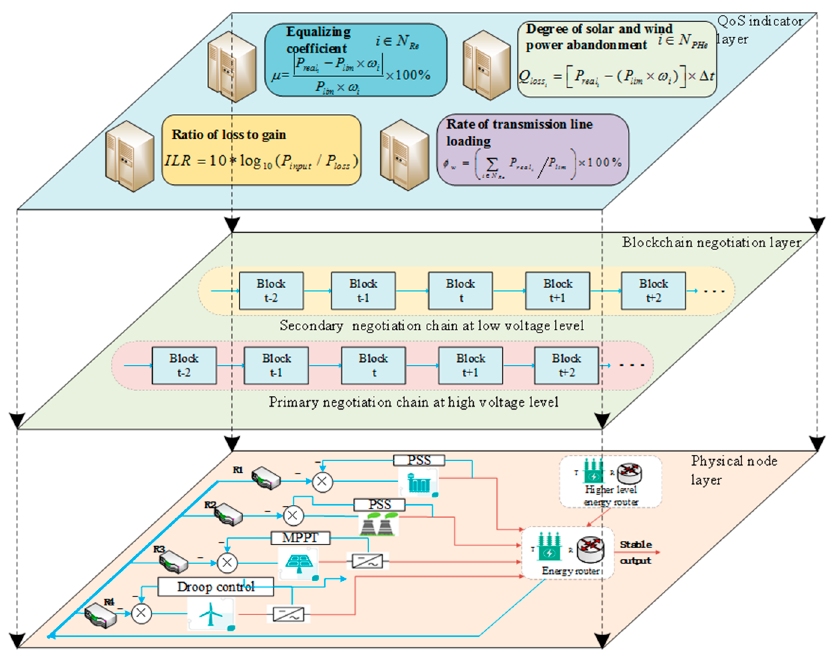
Figure 2. Node model of transmission and distribution network energy router .